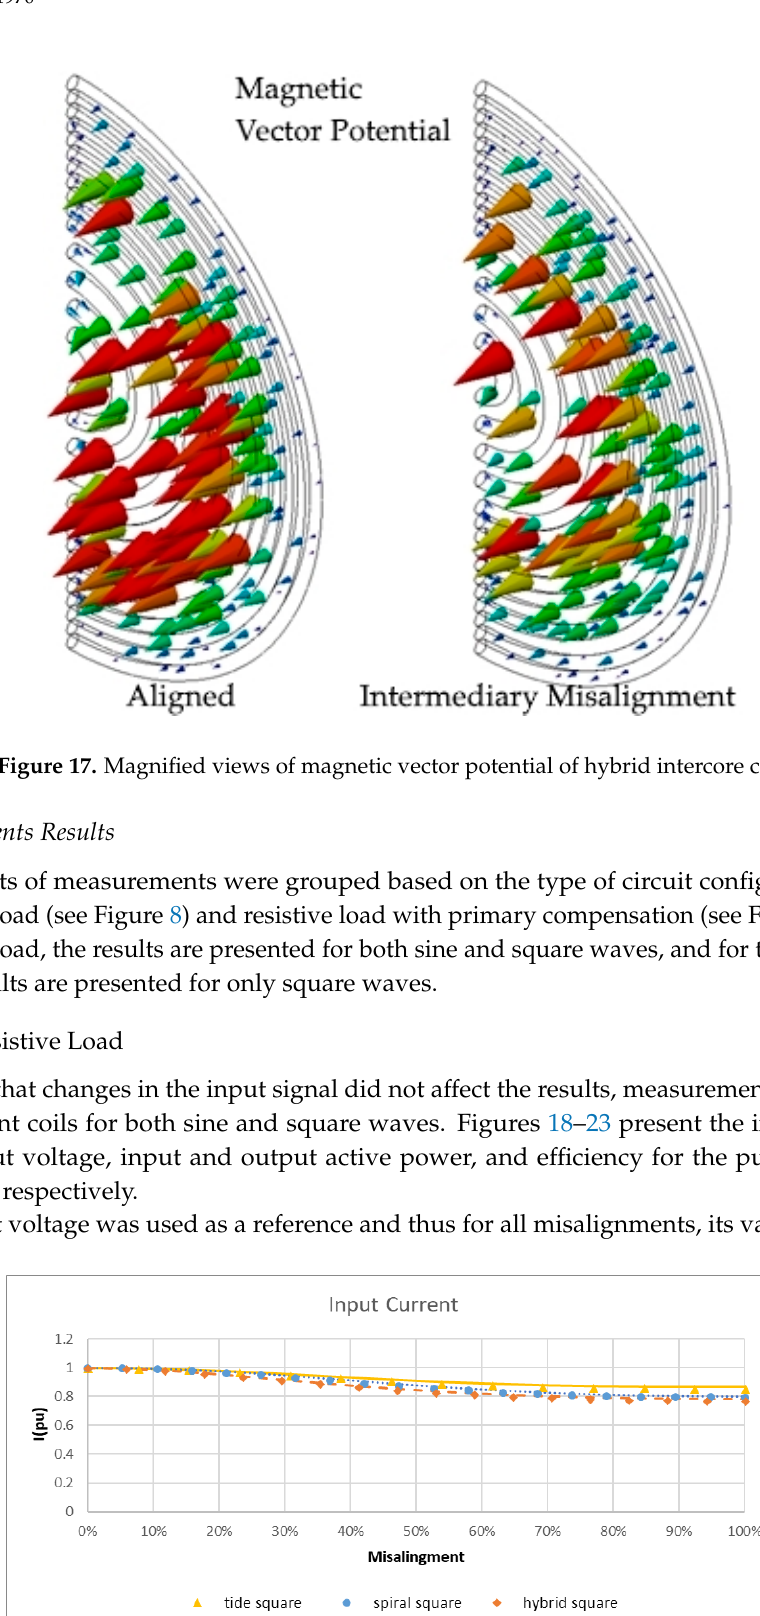
Figure 18. Measured input current for pure resistive load.